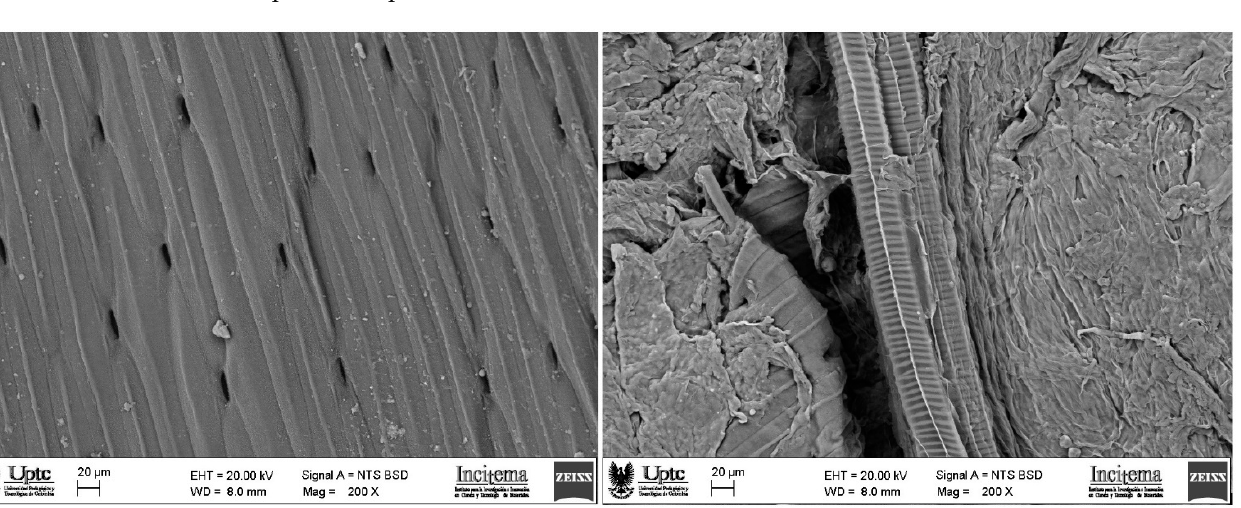
Figure 1. SEM images of Welsh onion leaves before ( left ) and after ( right ) ultrasonic processing.